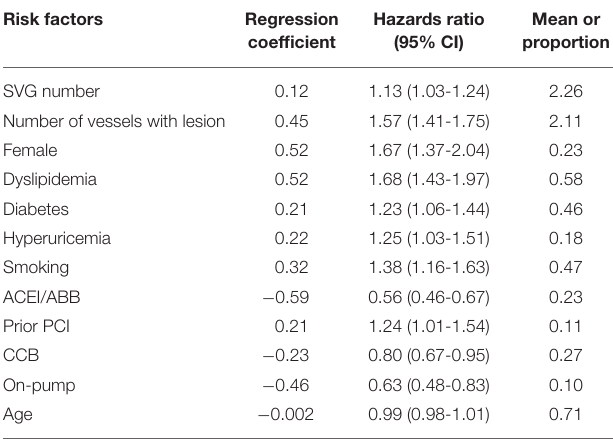
TABLE 2 | Independent predictors for late SVG occlusion in the model. TABLE 3 | Predictors from Cox proportional hazard model used in the